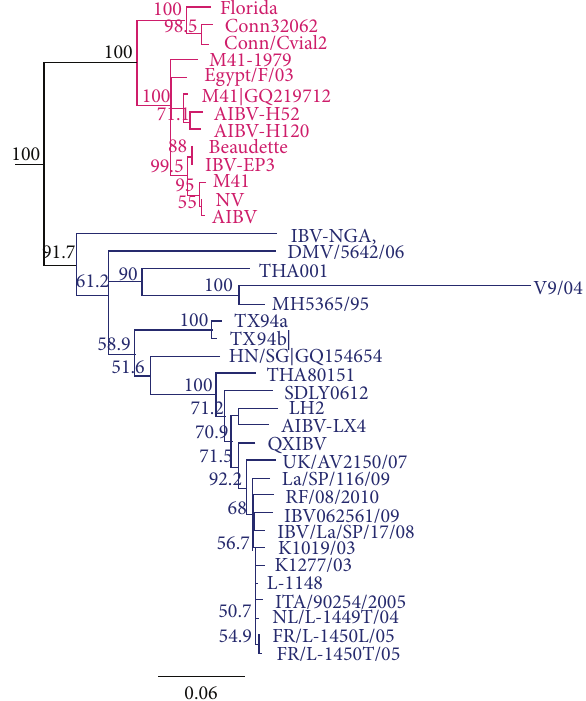
Figure 2: Neighbour-joining phylogenetics showing relationship in S1- glycoprotein of classical (pink) and variant (blue) IBV strains. The tree reliability was assessed using 1000-bootstrap confidence and branching pattern is supported by 91.7–100% bootstraps values and associated taxa show 82% pairwise identity. Phylogenetic analysis was carried out using Geneious software version